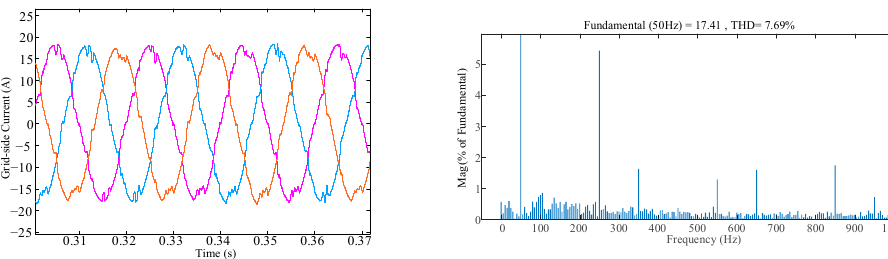
Figure 14. Simulation results of grid currents with switching frequency of 40 kHz.